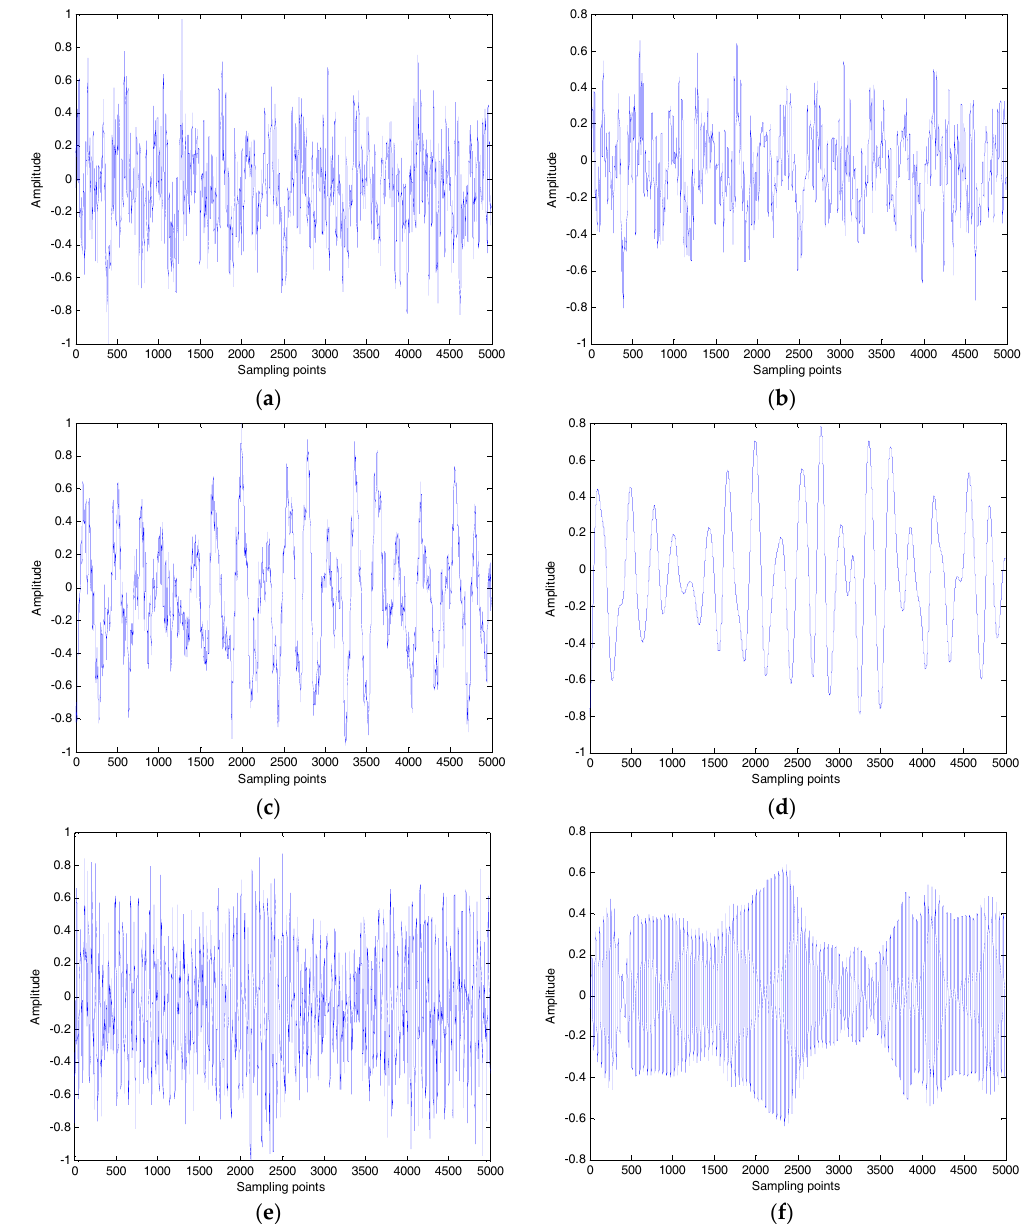
Figure 13. Three kinds of ship-radiated noise (SN). ( a ) Ship 1 without denoising; ( b ) Ship 1 after denoising; ( c ) Ship 2 without denoising; ( d ) Ship 2 after denoising; ( e ) Ship 3 without denoising; ( f ) Ship 3 after denoising.